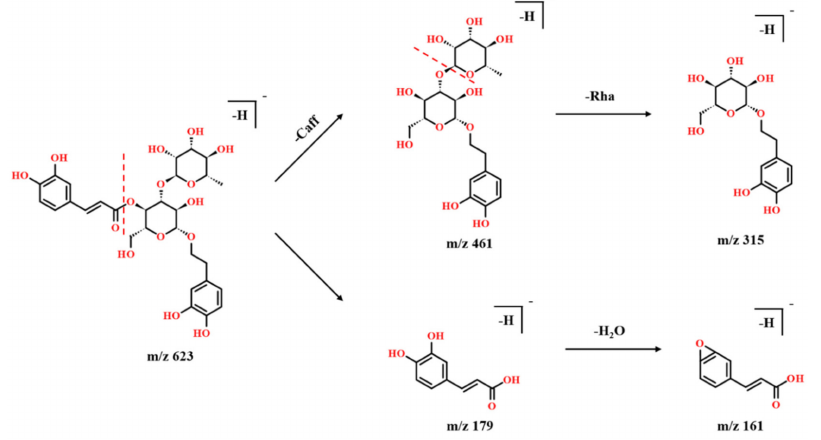
Figure 3. The possible fragmentation pathways of acteoside (compound 42 ) in the negative ion mode. The [M-Glc-H] − and [M-Glc-H 2 O-H] − ions detected at m / z 315 and 298 belong